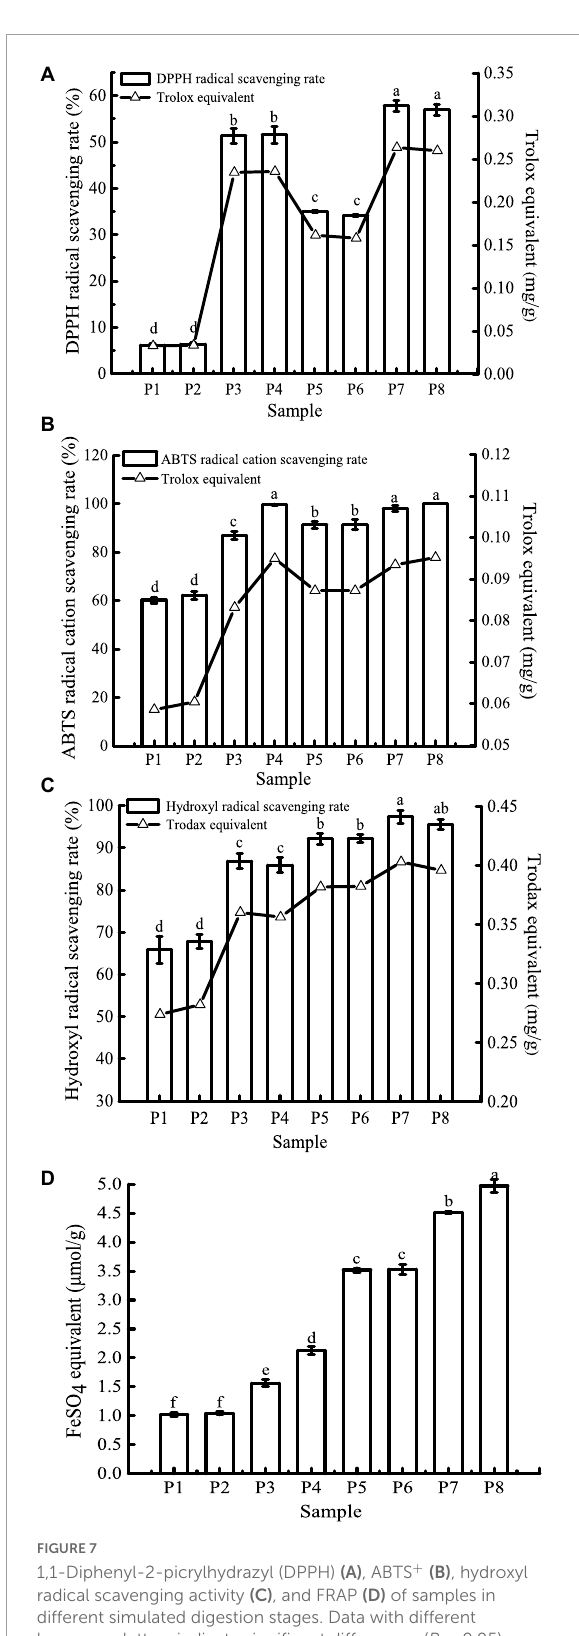
FIGURE7 1,1-Diphenyl-2-picrylhydrazyl (DPPH) (A) , ABTS + (B) , hydroxyl radical scavenging activity (C) , and FRAP (D) of samples in different simulated digestion stages. Data with different lowercase letters indicate significant differences ( P <